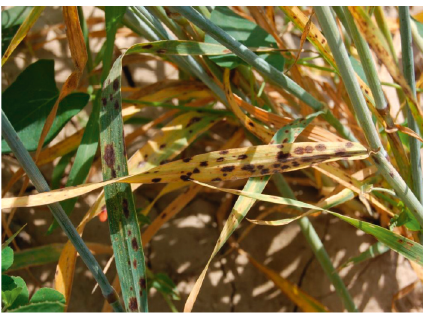
Figure 1: Symptoms of spot blotch on spring barley leaves from the surveyed experimental plots in this study.